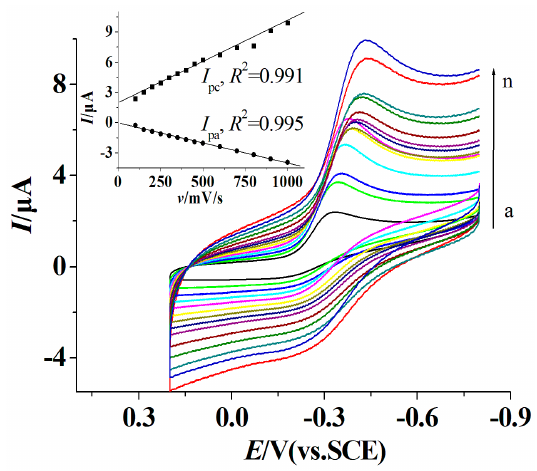
Figure 5. CVs of the AuNPs/GOx–PGR/GCE (glassy carbon electrode) in N 2 saturated PBS with different scan rates (from a to n: 100, 150, 200, 250, 300, 350, 400, 450, 500, 600, 700, 800, 900, 1000 mV/s).